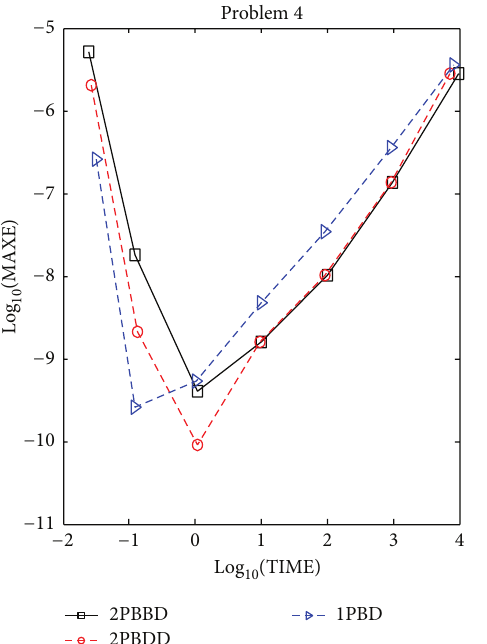
Figure 8: Graph of Log 10 ( MAXE ) plotted against Log 10 (𝐻) for Problem 4.